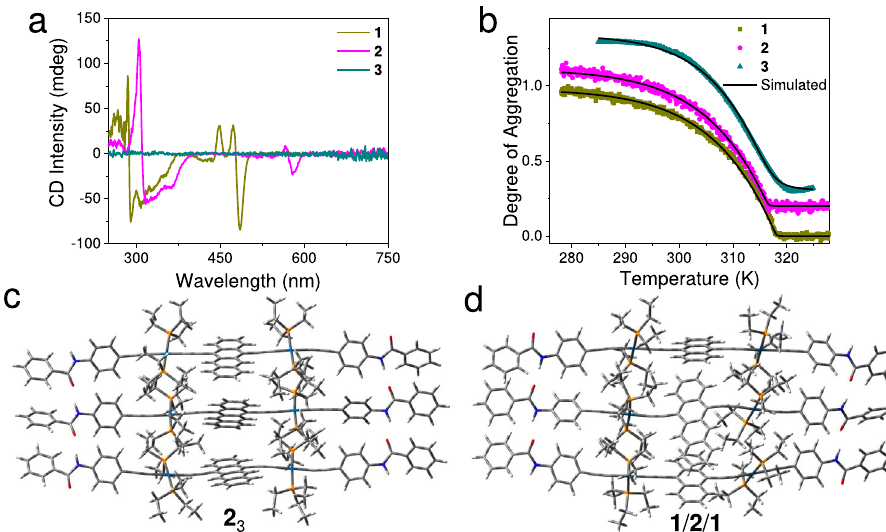
Fig. 3 Supramolecular polymerization behaviors. a CD spectra (1 mm cuvette, 298 K) for 1 – 3 in MCH ( c : 2 × 10 − 4 mol L − 1 for 1 or 2 , and 8 × 10 − 5 mol L − 1 for 3 ). The lower concentration of 3 is ascribed to its poor solubility in MCH. b Non-sigmoidal heating curves acquired via monitoring CD intensity changes of 1 – 2 ( λ : 486 nm for 1 and 579 nm for 2 ), together with the absorption intensity changes of 3 ( λ : 709 nm) ( c : 1.4 × 10 − 4 mol L − 1 for 1 or 2 , and 8 × 10 − 5 mol L − 1 for 3 in MCH). In panels, the curves are shown with a 0.1 offset. Data and fi t are represented as colored and black lines, respectively. All melting curves were fi tted by the mass balance model developed by Markvoort and ten Eikelder 47 . c , d Optimized geometries of trimeric species 2 3 and 1 / 2 / 1 . For both optimized geometries, non-metallic elements were described by a 6-31 G basis set, while Lanl2dz effective core potential developed by Los Alamos National Laboratory was employed to describe Pt(II) ions. Dispersion-corrected exchange functional ω b97xd was employed to optimize geometries of the trimeric species.